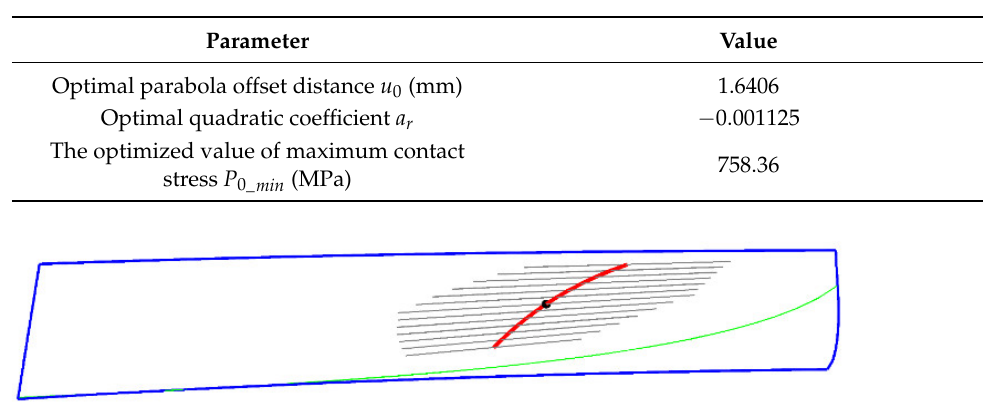
Figure 11. The optimized contact diagram (gray shades: contact area; red line: contact path; black point: maximum contact stress; green line: transition curve; blue lines: tooth borders).